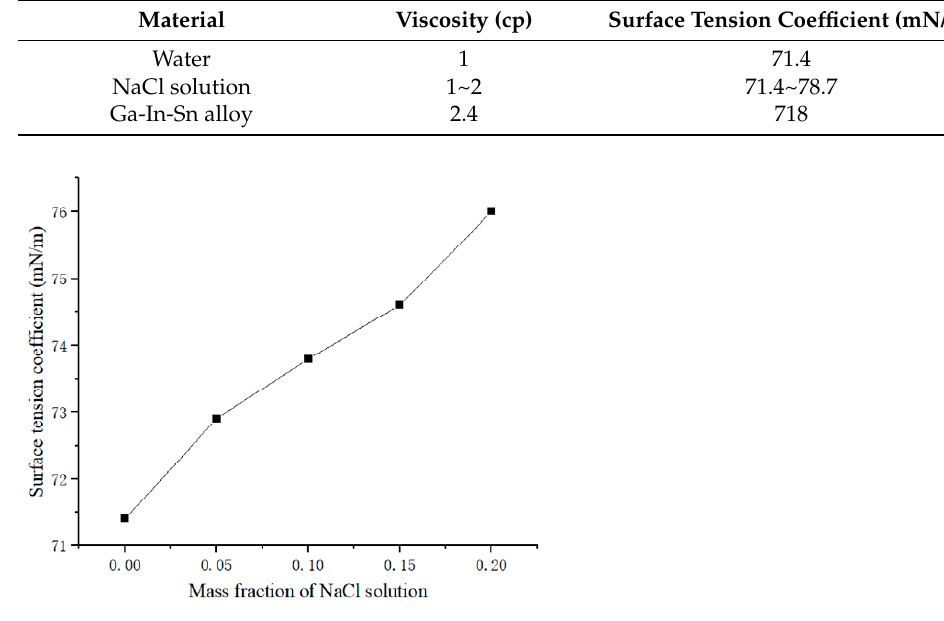
Figure 3. Variation of surface tension coefficient of NaCl solution with mass fraction.